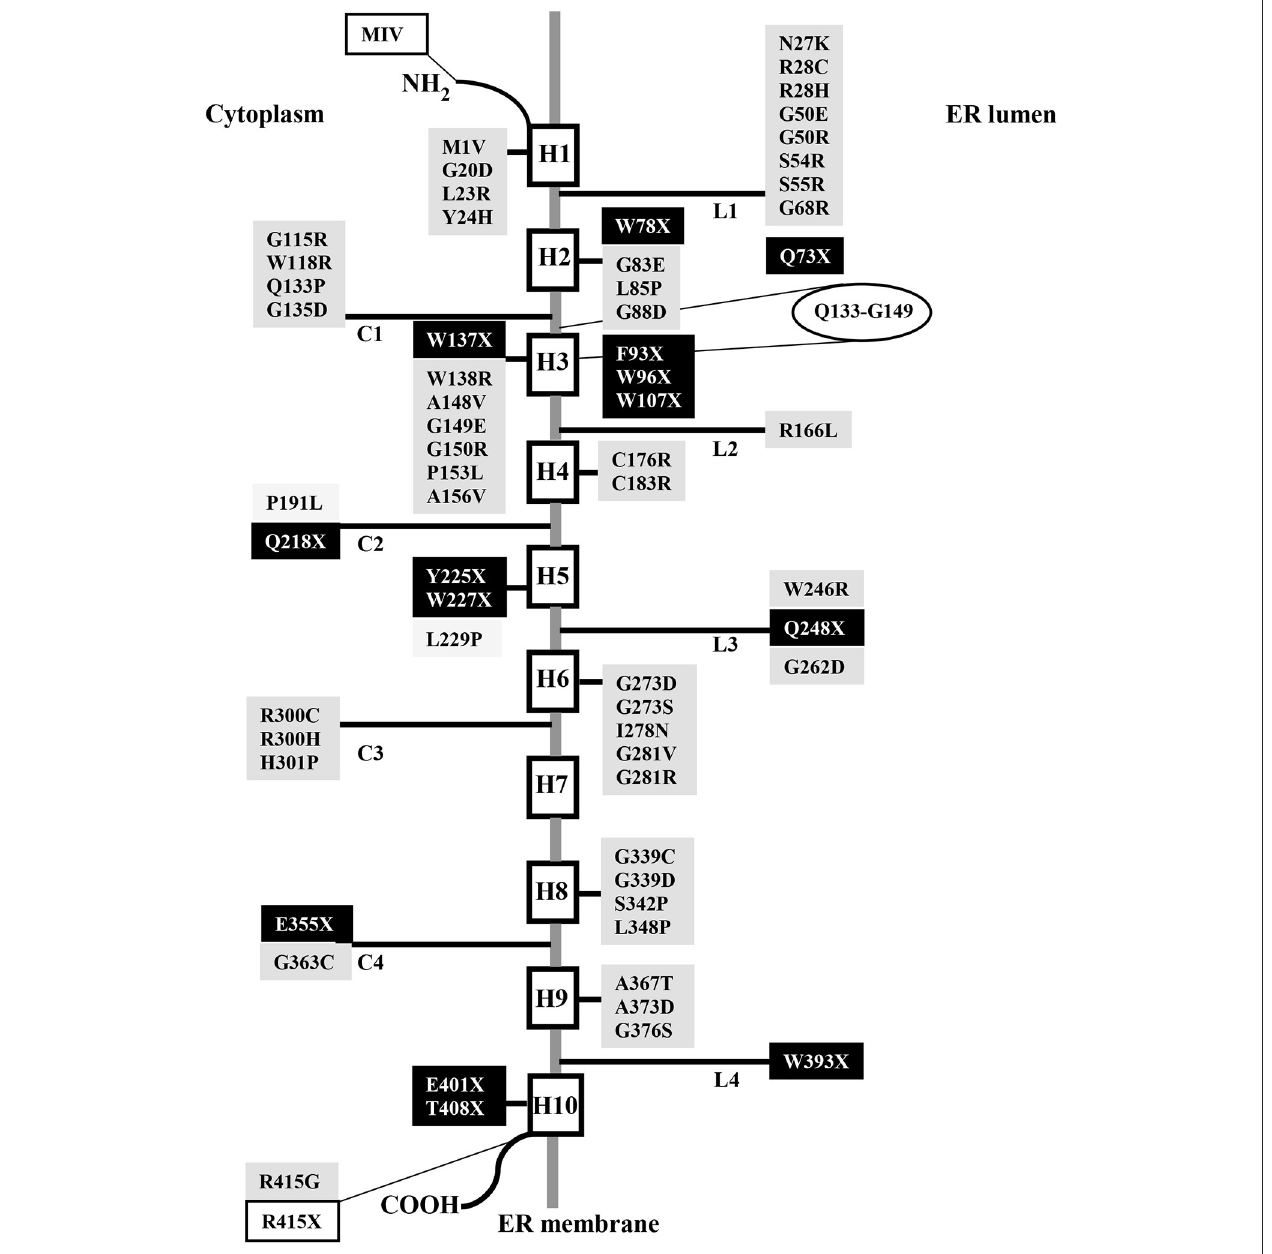
FIGURE 2 | Schematic topological model of human G6PT displaying nonsense and missense mutations identified in GSD-Ib patients. Nonsense and missense mutations are highlighted in black or gray, respectively. The extension of the consensus sequence is reported in an ellipse. White boxes represent mutations that eliminate the N- or C- terminal